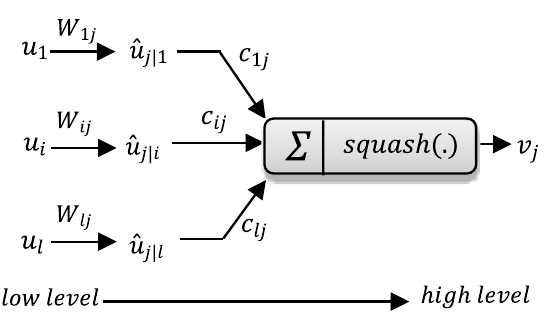
Fig. 1 Illustration of CapsNet operator